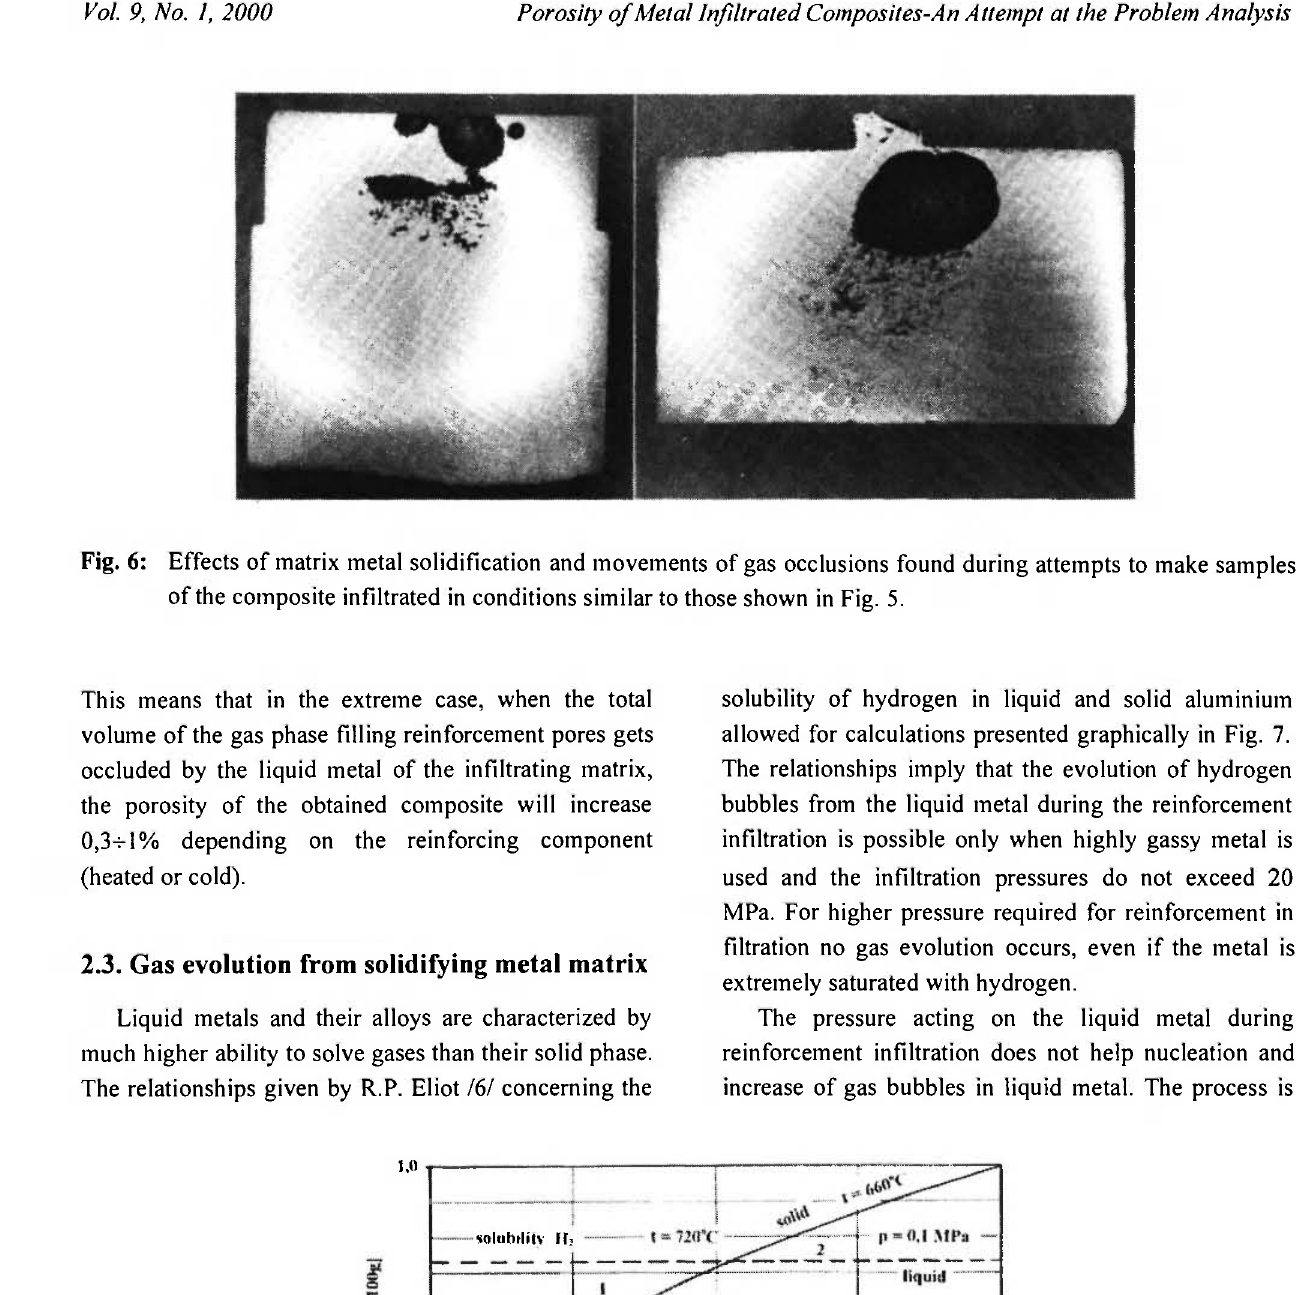
Fig. 7: Conditions for the formation of hydrogen bubbles in the AlSil 1 alloy as a function of